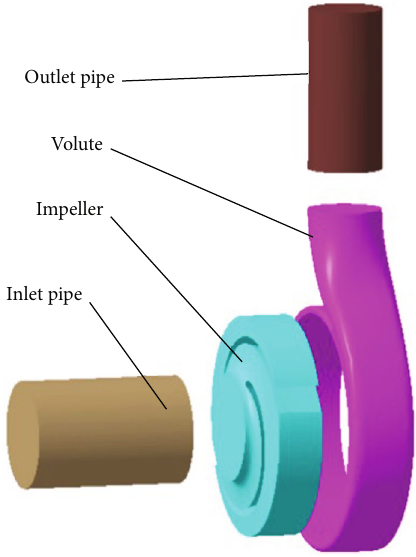
Figure 3: Schematic diagram of fl uid